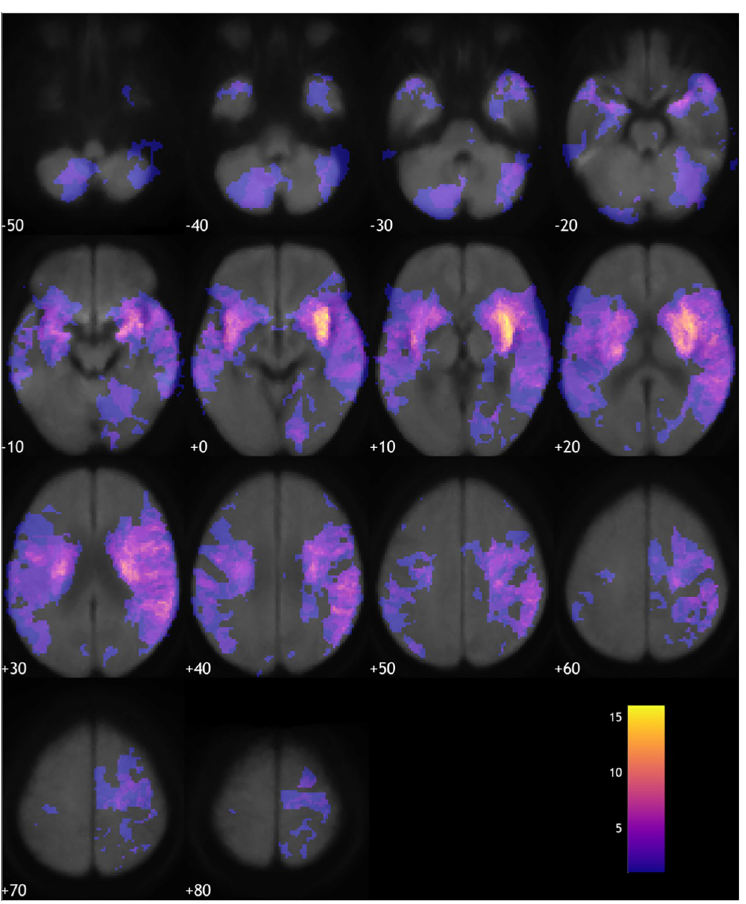
Fig 1. Lesion overlap map. This figure shows a color coded map indicating the number of subjects that have a lesion at a particular voxel, overlaid on an average diffusion-weighted image in standard Montreal Neurological Institute space (left in image is left in the brain, coordinates indicate position along the z-axis, i.e. inferior to